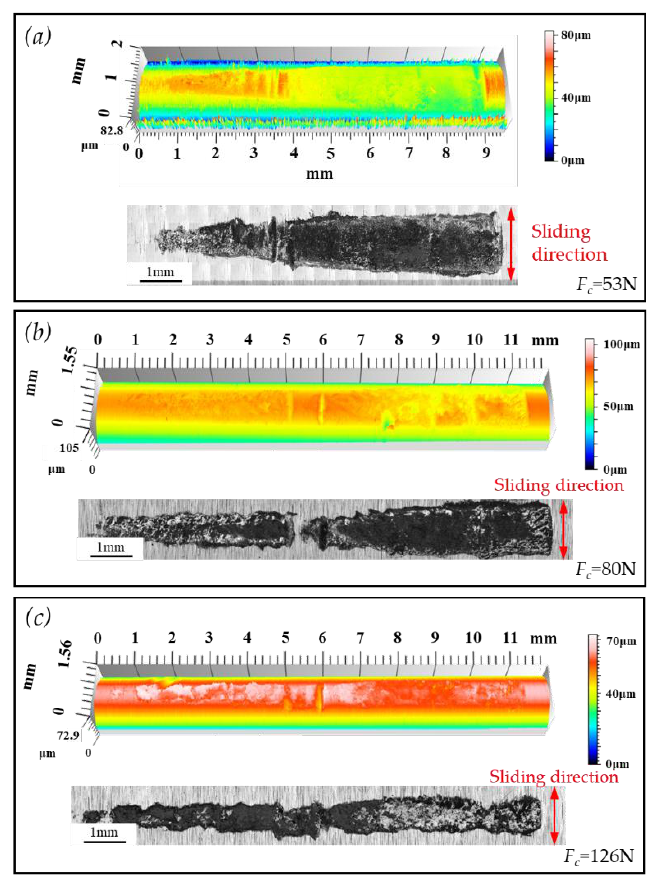
Figure 11. 3D morphology of wear scar and worn surface under operating conditions: ( a ) clamping force of 53 N; ( b ) clamping force of 80 N; ( c ) clamping force of 126 N.